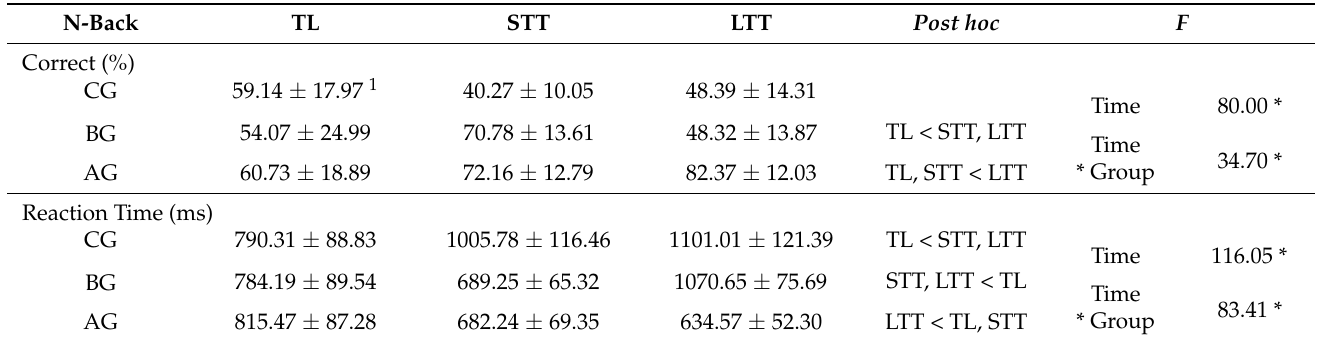
Table 3. Change of working memory of cognitive function by area (N = 45).